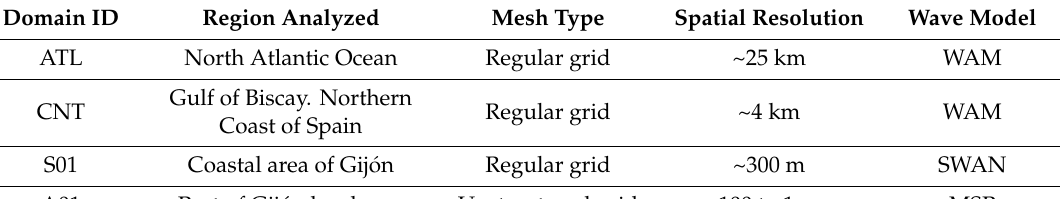
Table 2. Wave model domains, spatial resolution, and wave model from the downscaling scheme.